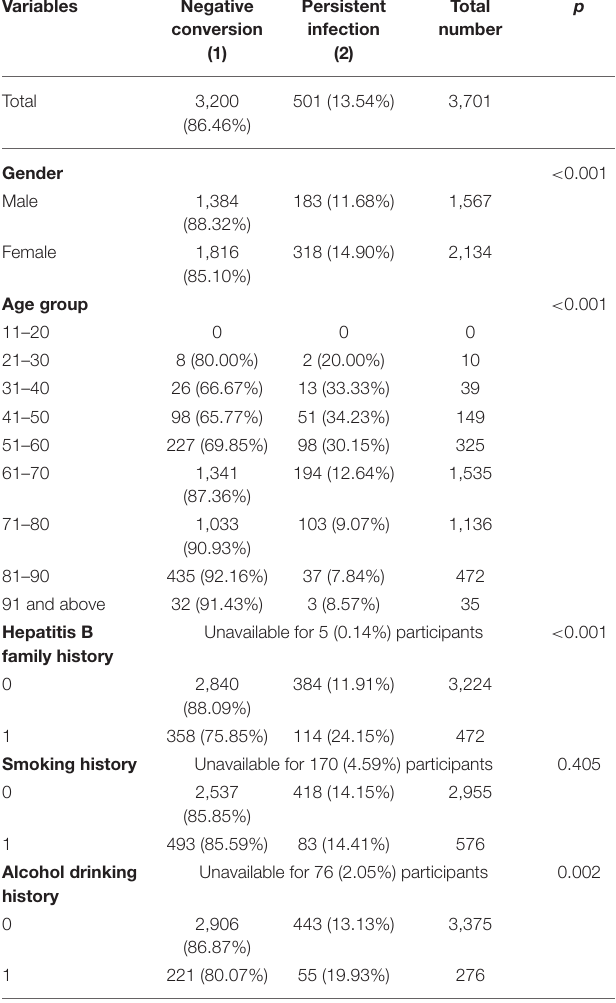
TABLE 2 | Outcomes and univariate analysis of HBsAg positive conversion.